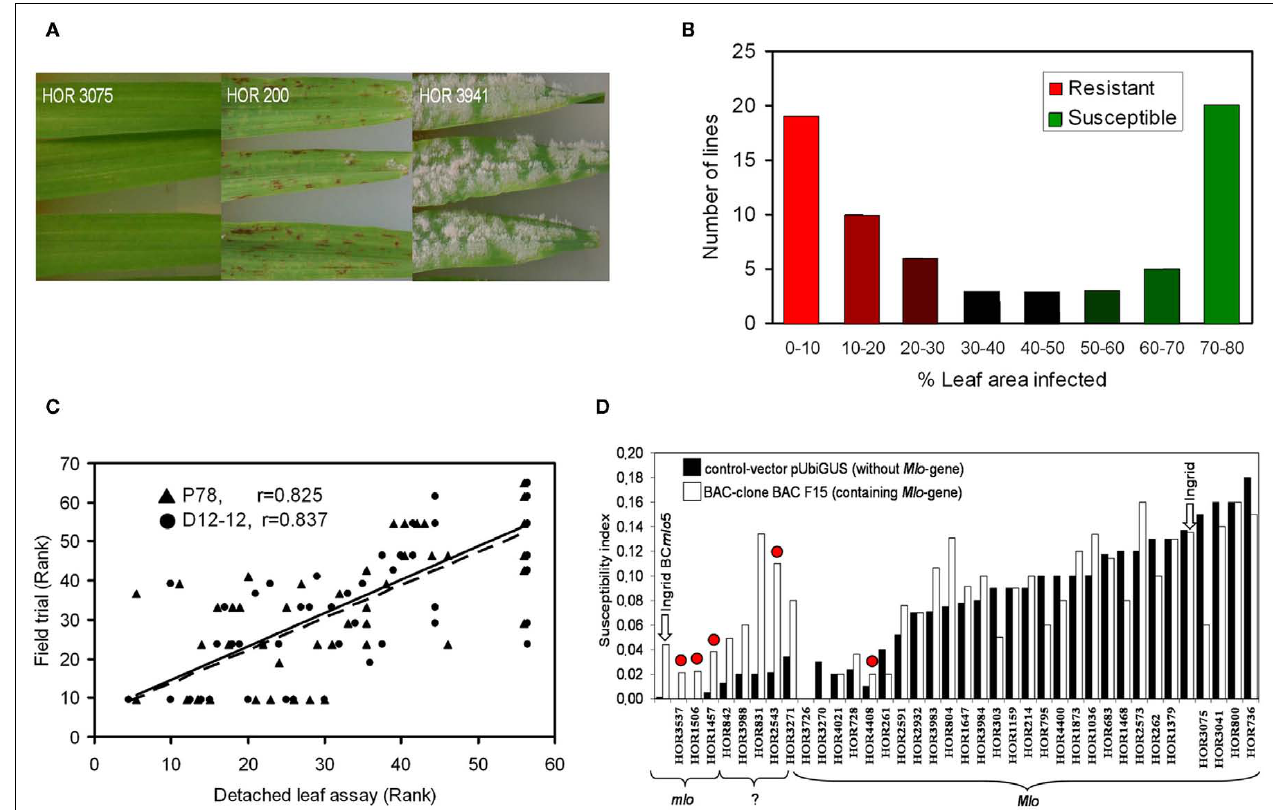
of Bgh . Mean values from inoculations with both isolates are shown. (C) Correlation of seedling and adult-plant resistance determined by a detached leaf assay of greenhouse-grown plants and in a field experiment performed in 2008 in Germany, respectively. (D) Functional assessment of mlo -allelic status of resistant accessions by Mlo BAC complementation. Red dots indicate genotypes carrying mlo-11